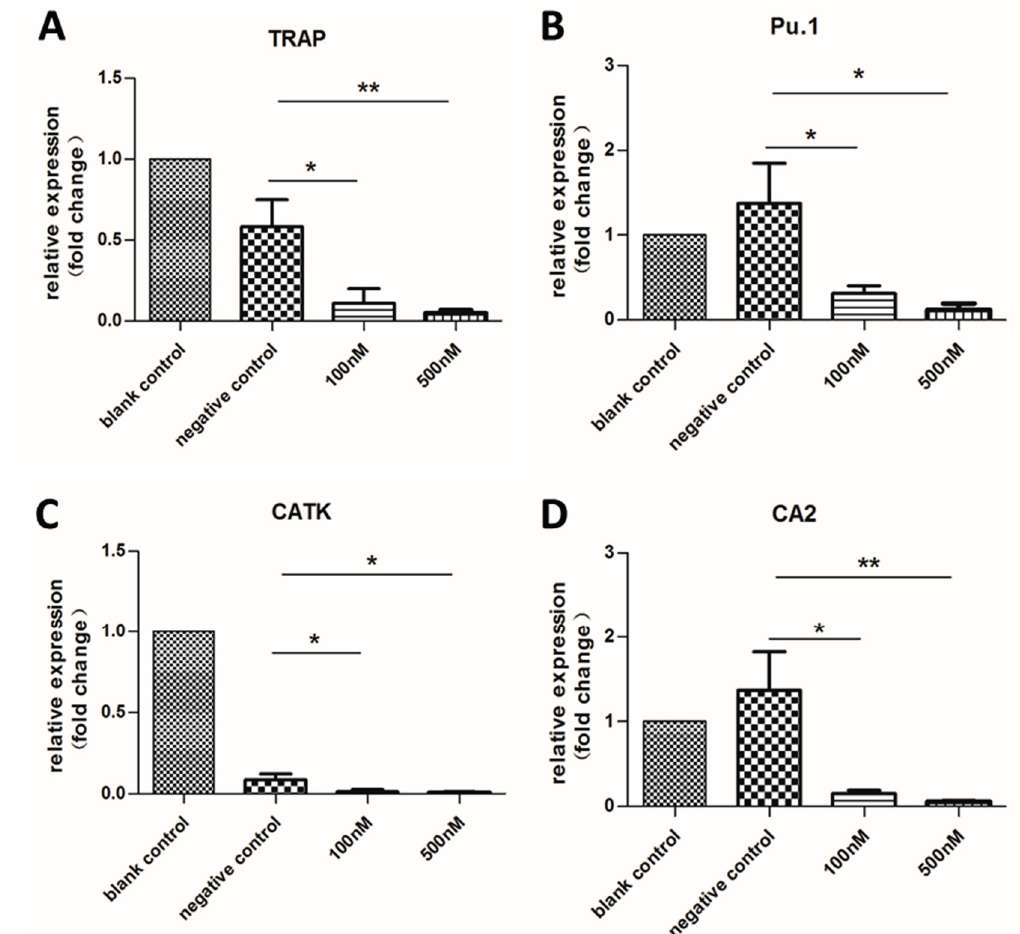
Figure 3. qRT-PCR analysis of OC-specific genes after 14 days of incubation with MS2 VLPs. Cells were stimulated with RANKL/M-CSF and treated with MS2 VLPs. The housekeeping gene glyceraldehyde-3-phosphate dehydrogenase (GAPDH) was chosen as an internal control. ( A – D ) represents expression levels of TRAP, Pu.1, CATK, and CA2, respectively. The relative expression levels of miRNAs were calculated by the 2 −ΔΔ C t method. * p < 0.05, ** p < 0.01. Each experiment was carried out in